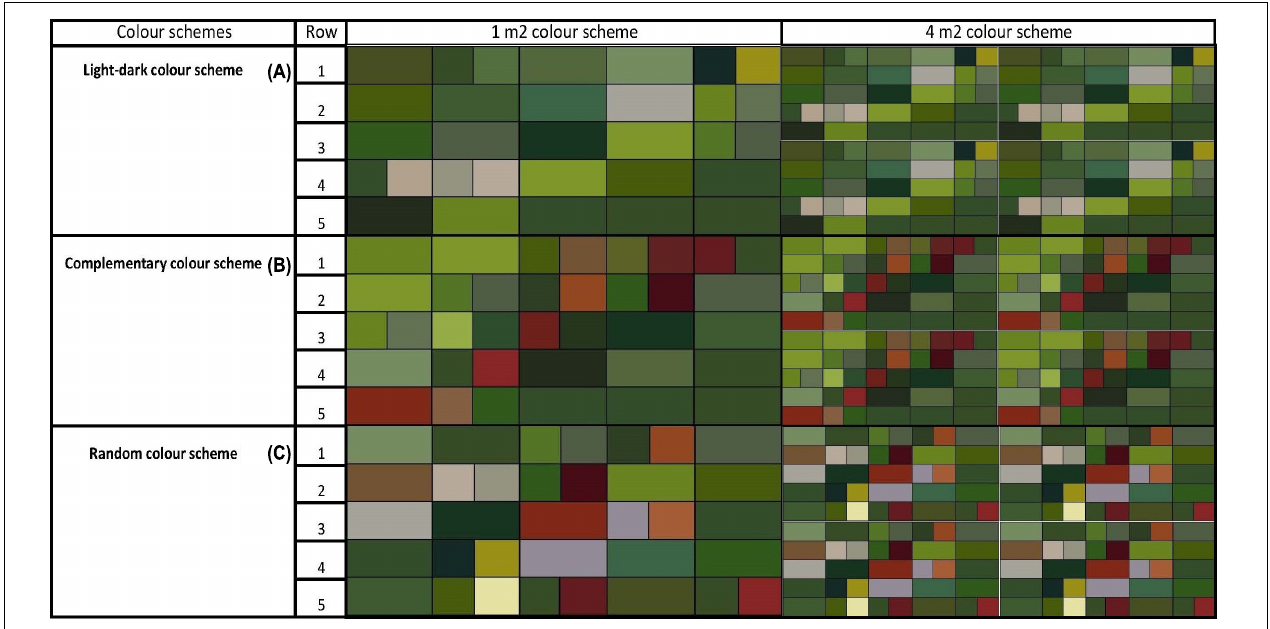
FIGURE 3 | Graphically rearranged plant designs of living walls using two colour schemes, light-dark (A) and complementary (B) and one random scheme (C) illustrated in 1 m 2 and 4 m 2 view.